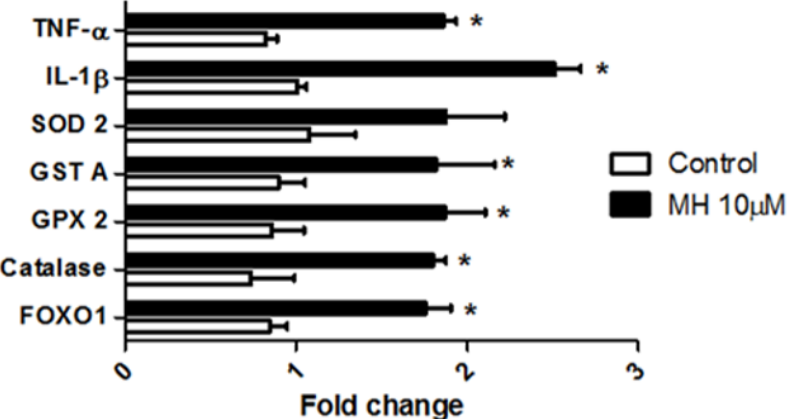
Figure 6. Embryos treated with MH lead to altered expression of genes involved in cell regulation, oxidative stress, and inflammation. Real-time RT-qPCR was performed on total RNA isolated from each group of embryos using described primers in Table 1 leading to the amplification of the target gene. RT-qPCR analysis of FoxO1, catalase, glutathione peroxidase (GPX2), glutathione-s-transferase (GSTA), superoxide dismutase 2 (SOD-2), Interleukin 1 beta (IL-1 β ), and tissue necrosis factor-alpha (TNF- α ) isolated from control and MH-treated embryos. Data were normalized to the eEf1 α polymerase chain reaction signal. Each value represents mean ± SEM ( n = 100, replicated four times). Statistical analysis was performed by two-way ANOVA followed by post-hoc Bonferroni test. * indicates values which are significant versus the respective control group ( p < 0.05).